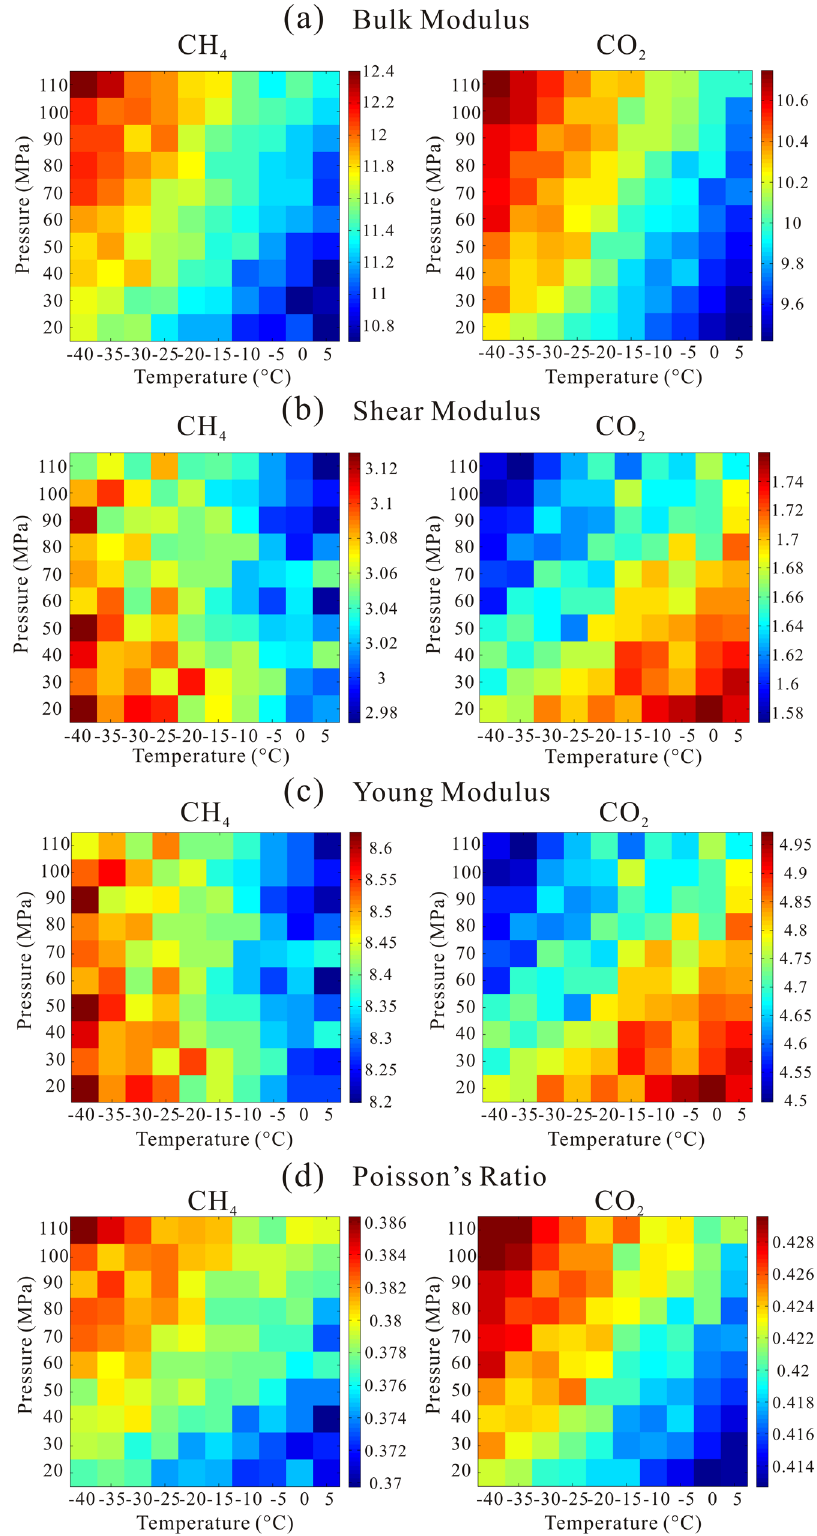
Figure 3. Diagrams of bulk modulus, shear modulus, Young’s modulus, and Poisson’s ratio of CH 4 and CO 2 hydrates with full occupancy from − 40 °C to 5 °C and 20 MPa to 110 MPa. Red represents large value of elastic moduli while blue represents small value with unit of GPa. Poisson’s ratio has no